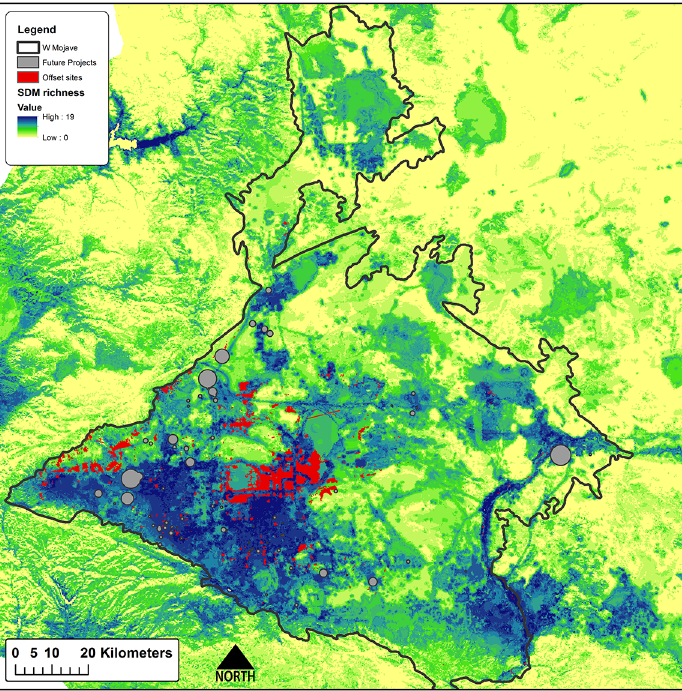
Fig 5. Max Cons offset sites. Max Cons offset sites (red) for hypothetical solar energy projects (gray) using a 2:1 offset ratio, over modeled species richness.